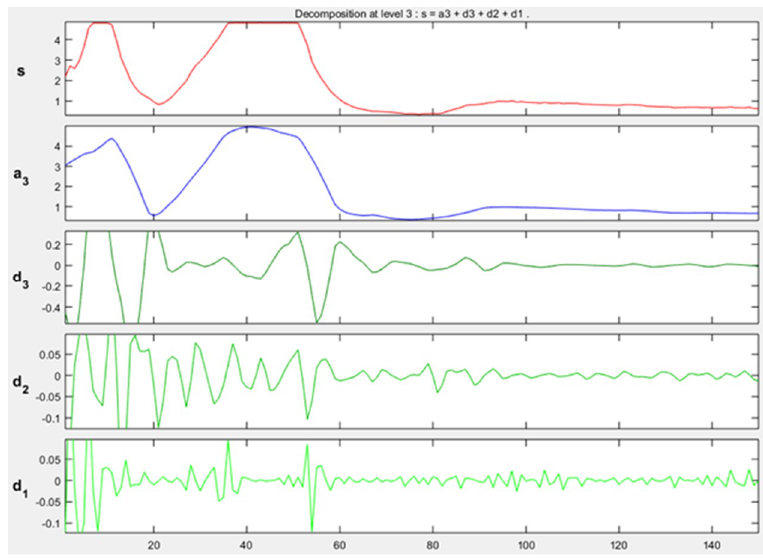
Figure 15. Example of approximation and detail coefficients, approximation to level 3 related to one upward-downward movement.